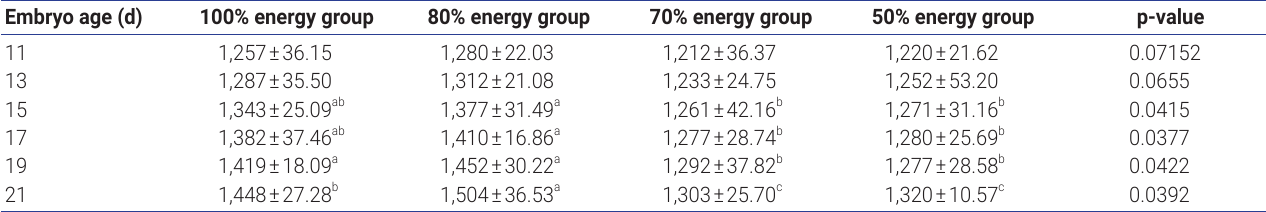
Table 6. Effects of maternal dietary energy restriction on breast sarcomere length of embryo Embryo age (d)